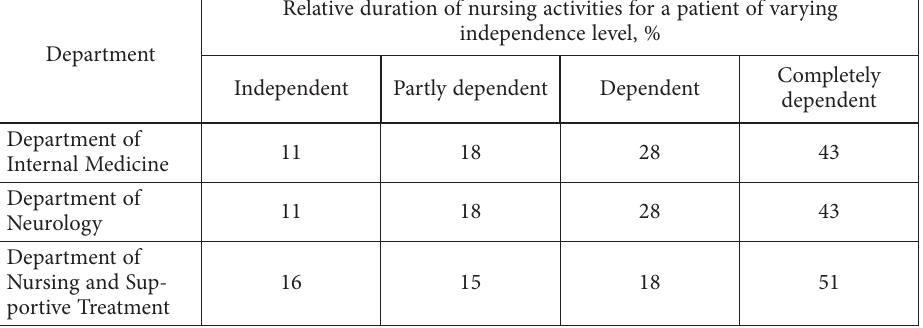
Table 4. Relative duration of nursing activities (duration of nursing tasks for a specific level of patient’s independence / total duration of time spent on nursing care of all the patients) for a patient of varying independence level,